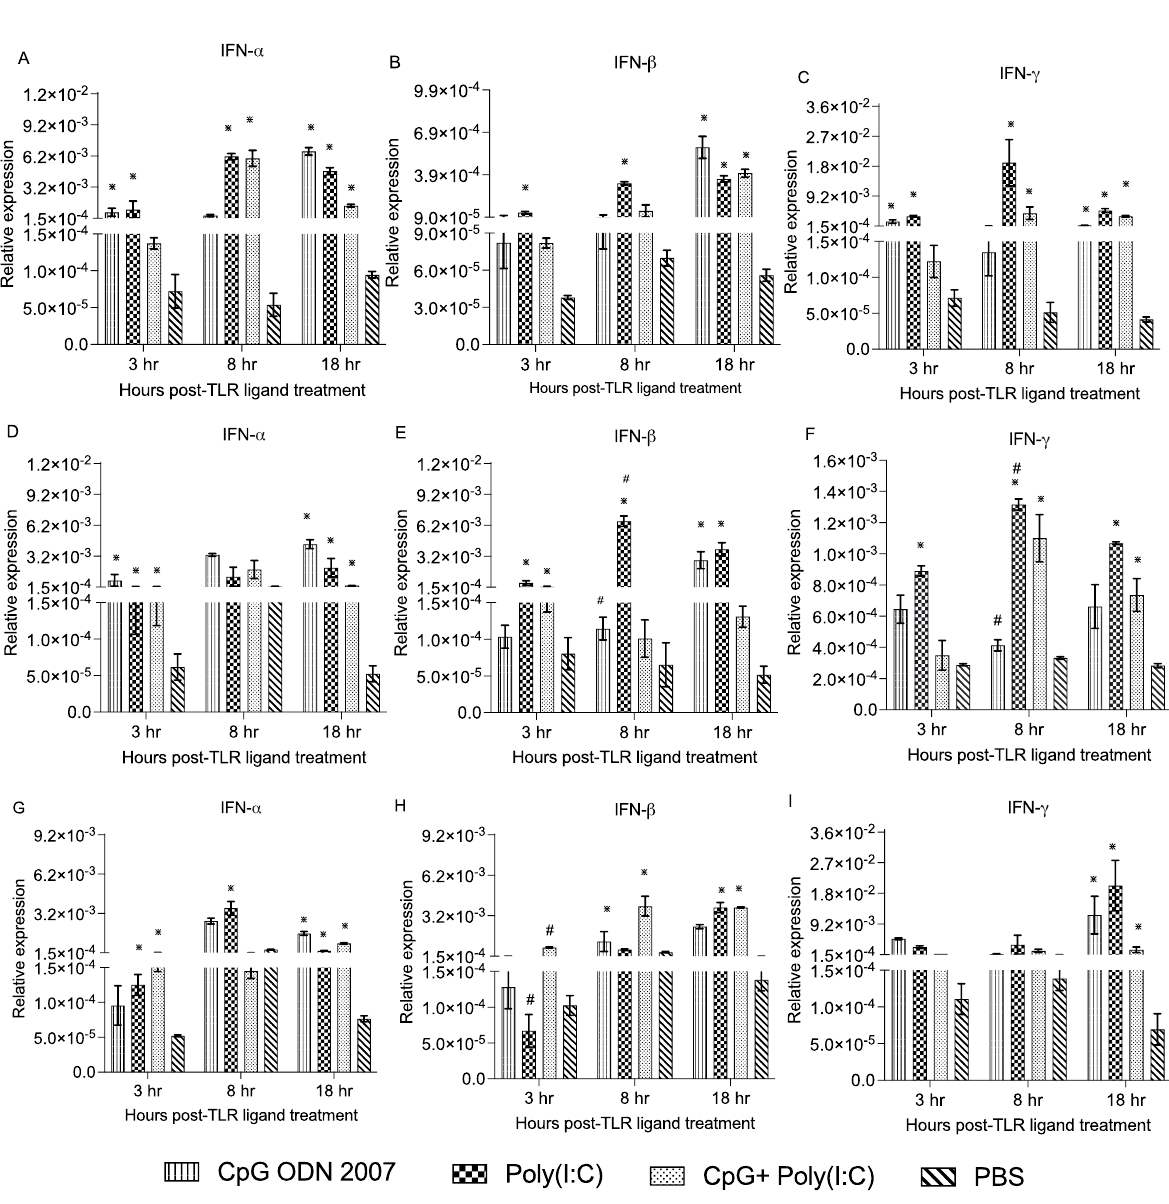
Figure 7. Relative gene expression of IFN-α, IFN-β and IFN-γ in the duodenum ( A – C ), jejunum ( D – F ) and ileum ( G – I ) at 3, 8 and 18 h post-CpG ODN 2007, poly(I:C) and combination treatment. Relative gene expression of IFN-α, IFN-β and IFN-γ at 3, 8 and 18 h post-TLR ligand treatment. Chickens were treated with CpG ODN 2007 (10 μg/chicken), poly(I:C) (400 μg/chicken) and a combination of CpG ODN 2007 (10 μg/chicken) + poly(I:C) (400 ug/chicken), or 100 μL PBS for the negative group. The plotted values represent the mean gene expression levels relative to B-actin ± standard error of the mean (SEM). Statistical significance was calculated using one-way ANOVA followed by Tukey’s multiple comparison test. The results were considered significant from PBS control p < 0.05 < 0.05 between two treatment